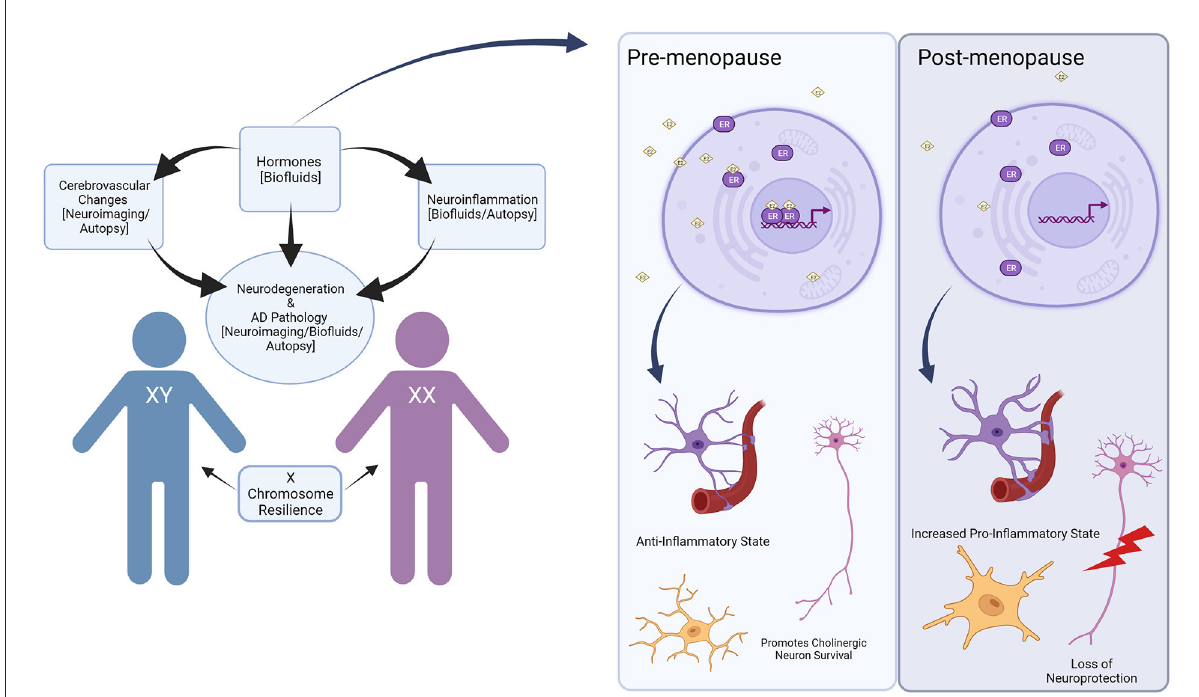
FIGURE1 Overview of sex differences in Down syndrome and Alzheimer’s disease. Hormones can contribute to cerebrovascular changes and neuroinflammation in the brain, which can lead to increased Alzheimer’s disease pathology. These changes can be identified through neuroimaging, biofluids, and autopsy studies, though only a handful have investigated sex differences directly. Hormones such as estrogen can have a particularly beneficial effect, which is then withdrawn during hormonal events such as menopause. In the pre-menopausal state, bioavailable estrogen (represented as E2) acts on estrogen receptors (ER) to promote an anti-inflammatory state in the brain while maintaining neuronal health. In the post-menopausal state, lower levels of estrogen lead to increased pro-inflammatory states and loss of neuroprotection. In addition to hormonal effects, the X chromosome may contribute to resilience in aging and improve cognitive outcomes, though this has not been studied in the context of DS. Created with